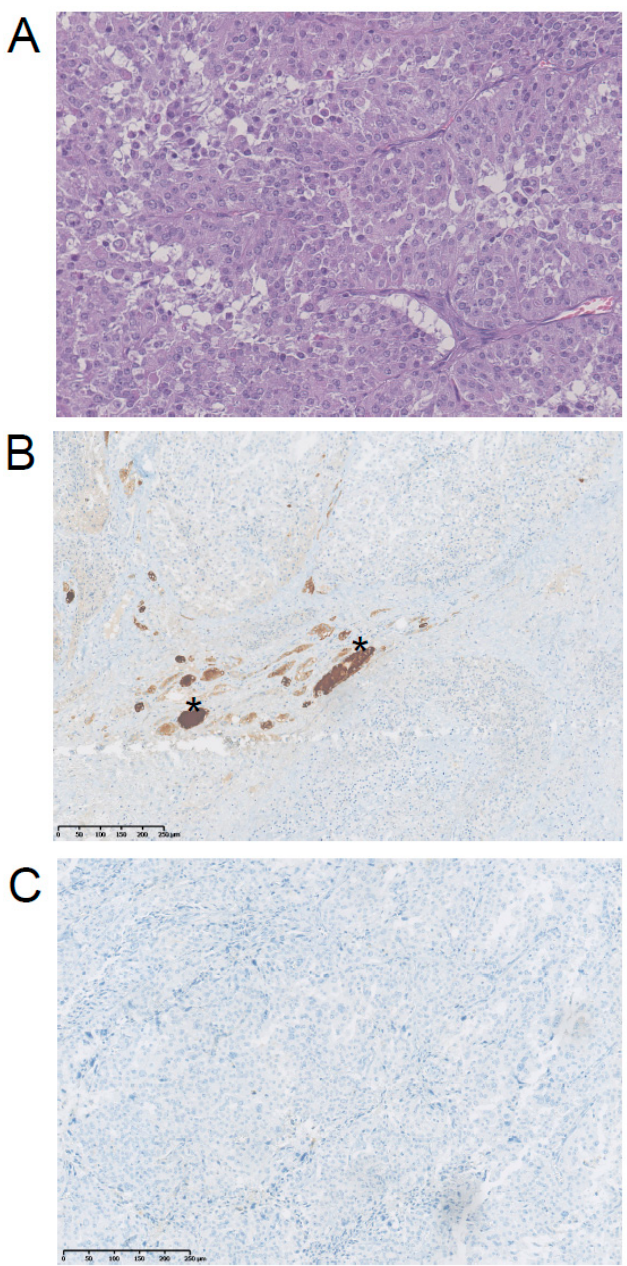
Figure 2. Immunohistochemical staining of the ATC primary tumor that developed in the context of a Hürthle cell carcinoma. ( A ) H&E staining of ATC with epithelial-paucicellular pattern (40×), ( B ) Tg staining was negative; positively stained follicles (stars) were normal cells entrapped by the tumor cells (internal control); (10×) ( C ) PD-L1 staining was negative (10×). Two years later, because of the appearance of a hacking cough, a 18-fluorodeoxyglucose (18-FDG) positron emission tomography (PET) scan was per-